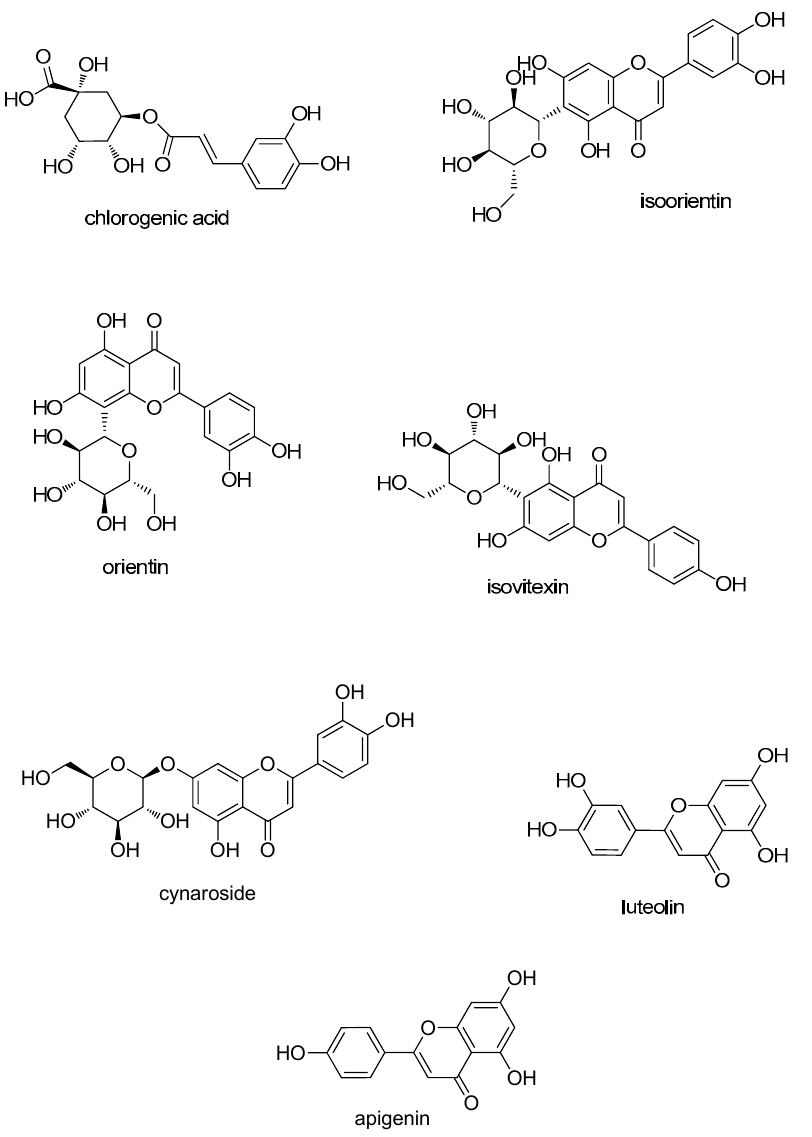
Figure 5. Chemical structures of the seven characteristic compounds.